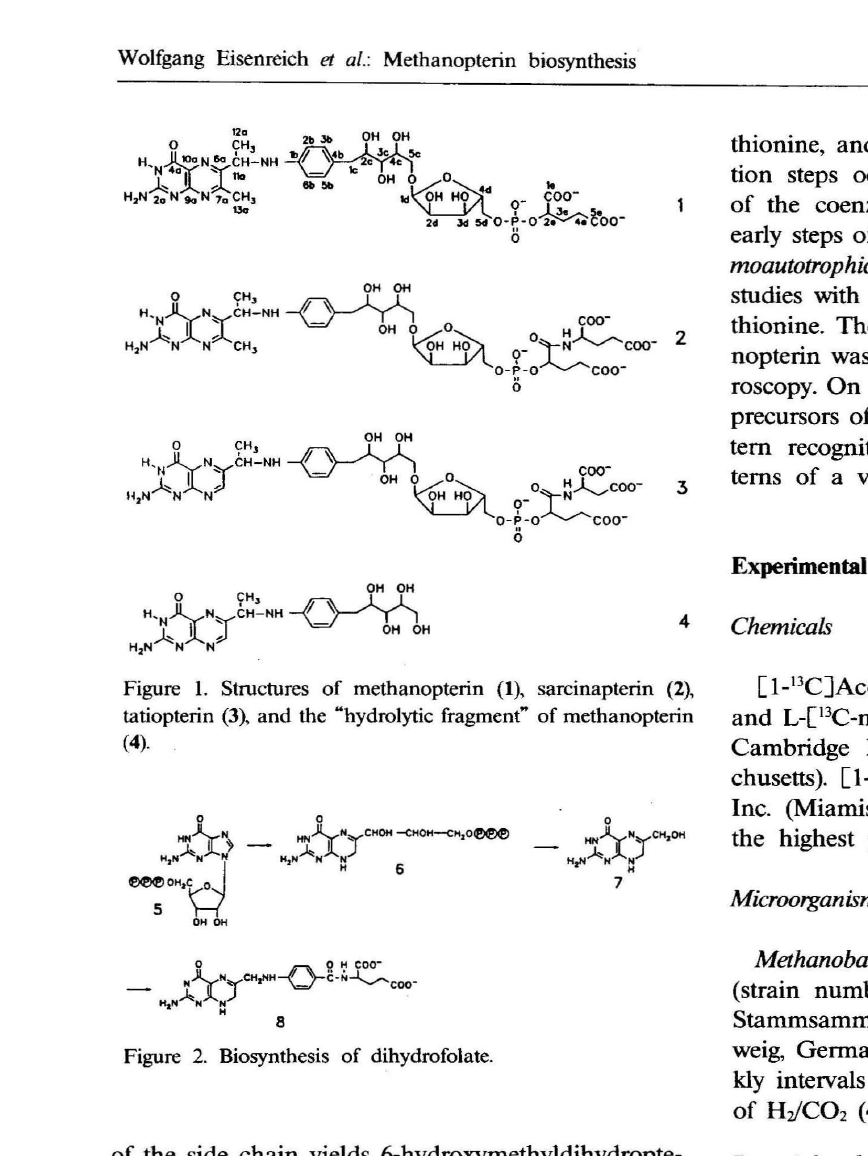
Figure 2. Biosynthesis of